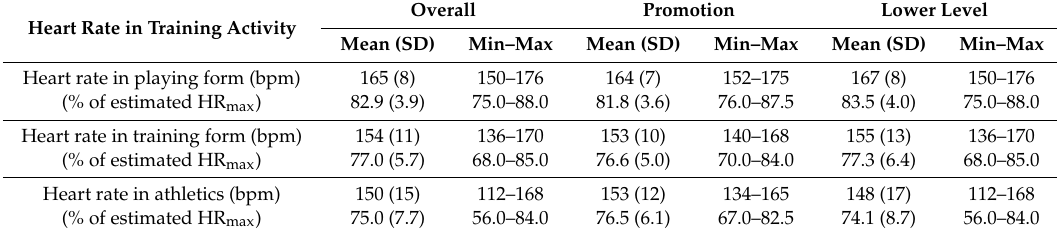
Table 4. Mean heart rates in di ff erent training activities during training sessions. Data presented as means with standard deviation and minimum and maximum.